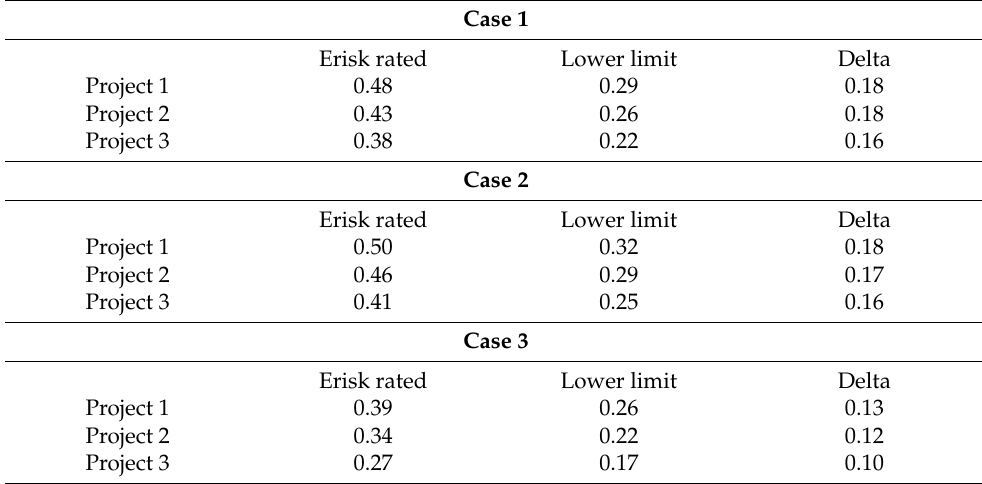
Table 10. Effective risk (ER) results for the three design projects considered in this study. Case 1 Erisk rated Lower limit